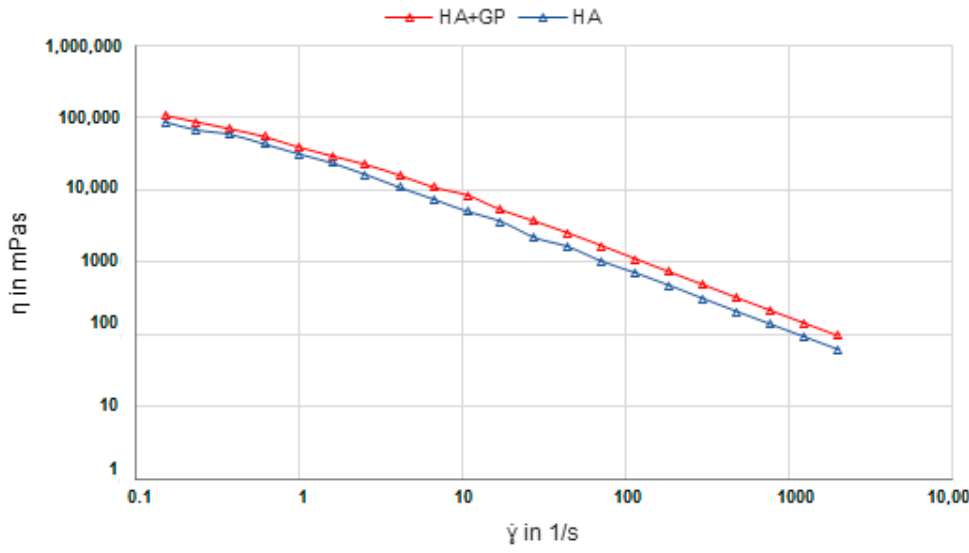
Figure 12. Shear viscosity measurements of pure HA hydrogel and genipin cross-linked HA hydrogel ( p = 0.0006).